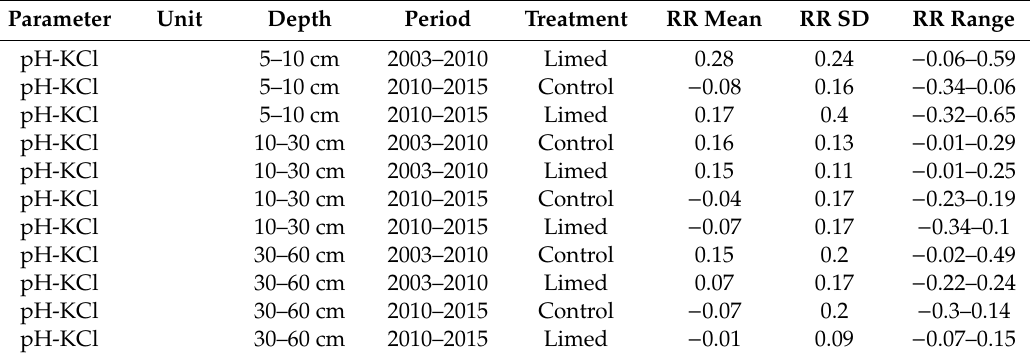
Table A4. G2 study site parameter pH-KCl, Mg, K, Na, Fe, Mn, H, C and N response ratios (RR)